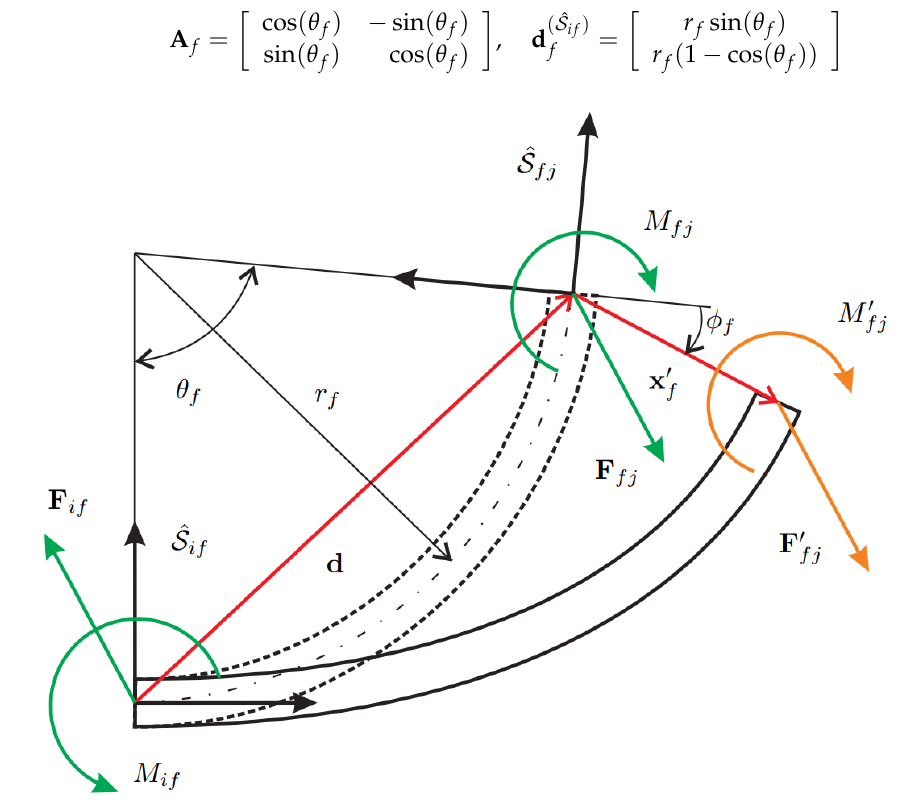
Figure 3. Static balance of a curved beam. Dashed line for the undeformed beam and a solid line for the deformed